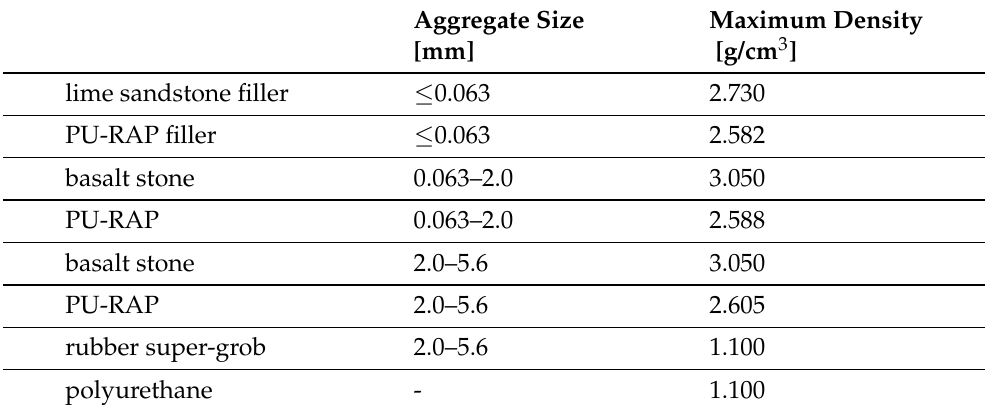
Table A1. Aggregate sizes and maximum densities of the designed